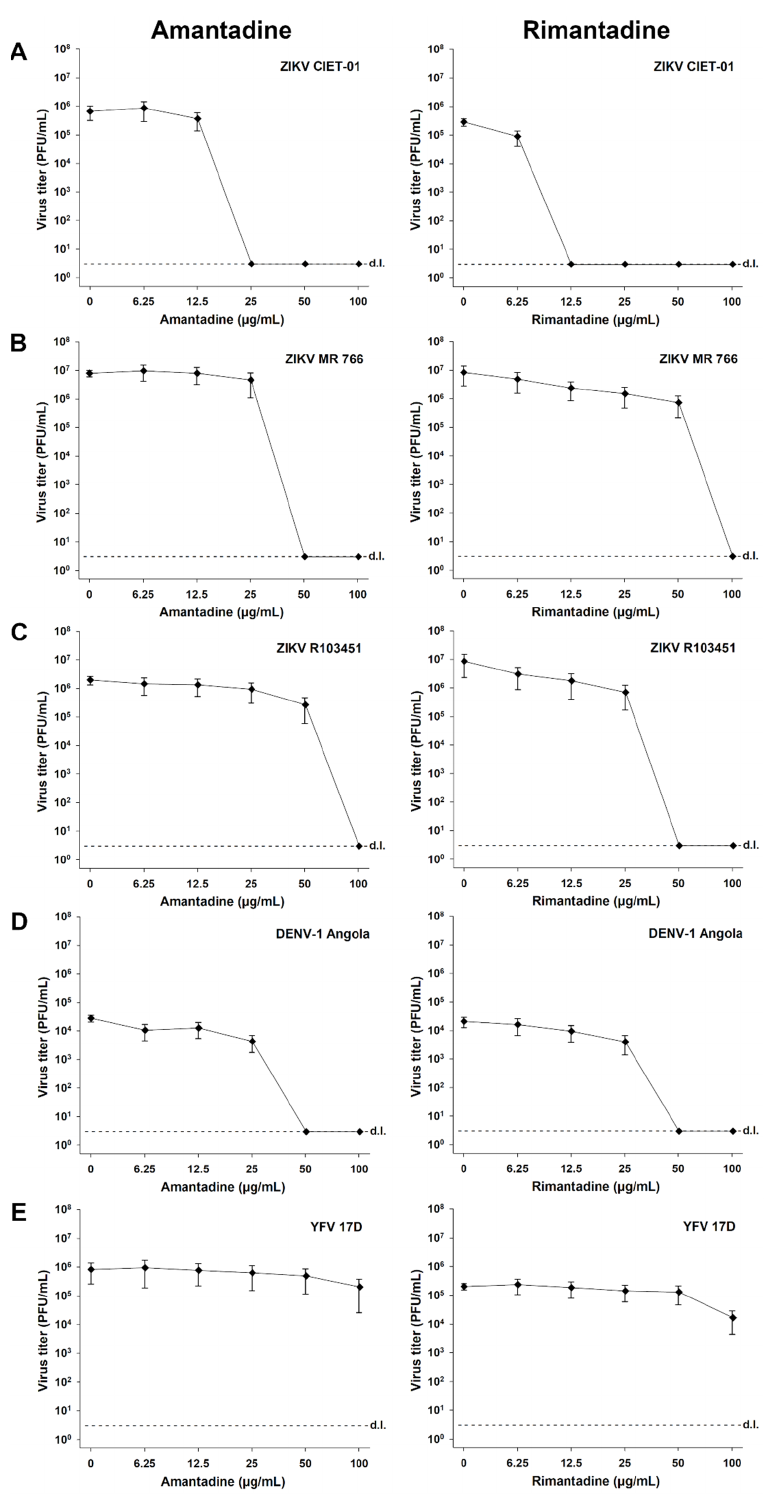
Figure 4. Amantadine and rimantadine hydrochlorides suppress the in vitro replication of different ZIKV strains, DENV-1, and YFV. Virion production was quantified by plaque assays of culture supernatants of Vero cells treated with different concentrations of amantadine or rimantadine hy- drochlorides at 48 h post-infection with ZIKV CIET-01 ( A ), ZIKV MR 766 ( B ), ZIKV R103451 ( C ), DENV-1 Angola ( D ), and YFV 17D ( E ) at a MOI of 0.1. Data are expressed as mean ± SD of three independent experiments. d.l. = assay detection